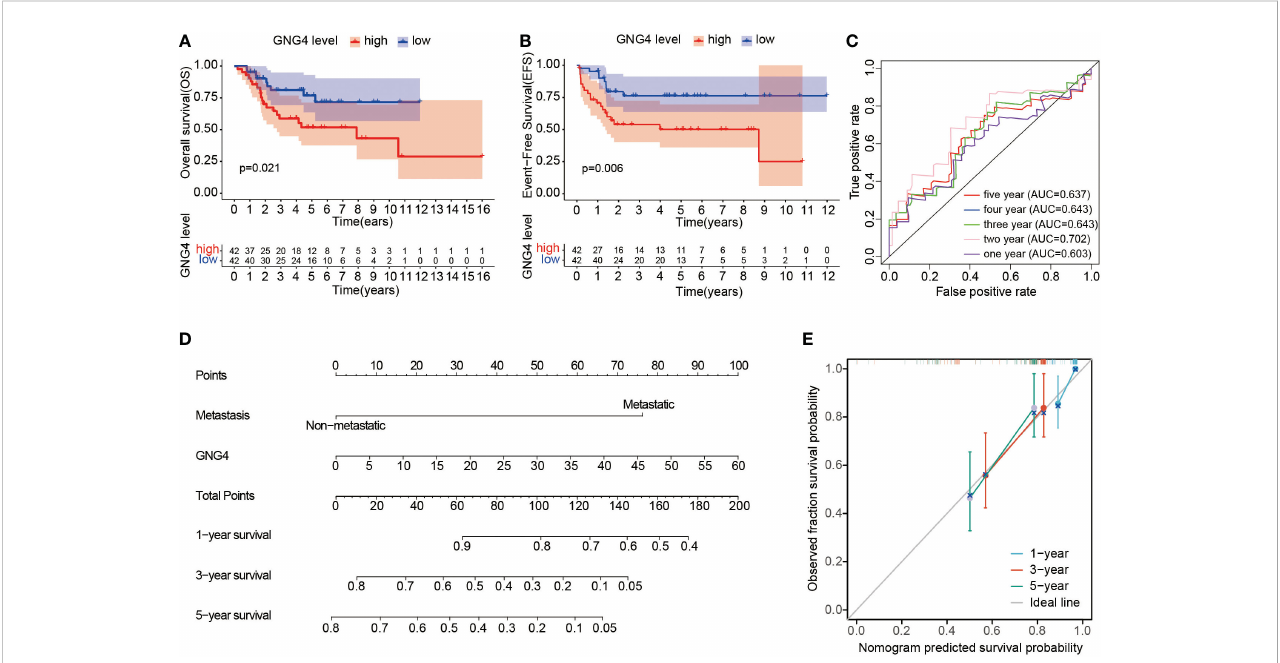
FIGURE 3 Prognostic value of GNG4 in OS. (A, B) In the TARGET dataset, patients with high GNG4 mRNA expression had worse overall survival time and EFS (n=84). (C) The AUC of GNG4 was determined in accordance with the time-dependent ROC curve. (D) Nomogram combining GNG4 and other prognostic factors. (E) Calibration curve of the nomogram.